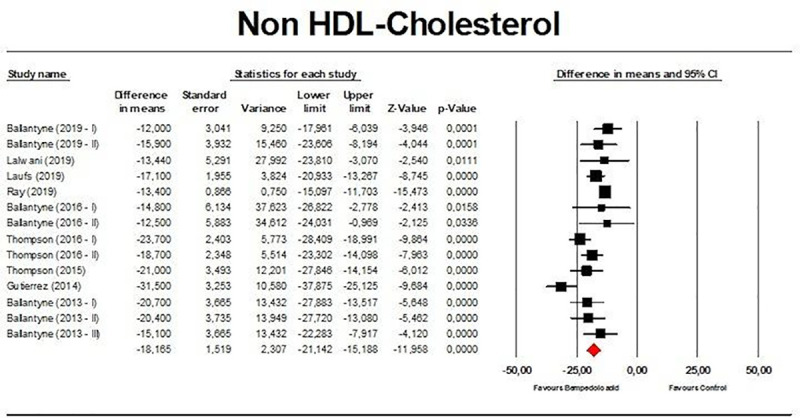
Forest plot displaying mean difference and 95% confidence intervals for the effect of bempedoic acid on plasma levels of non-high-density lipoprotein (HDL) cholesterol.